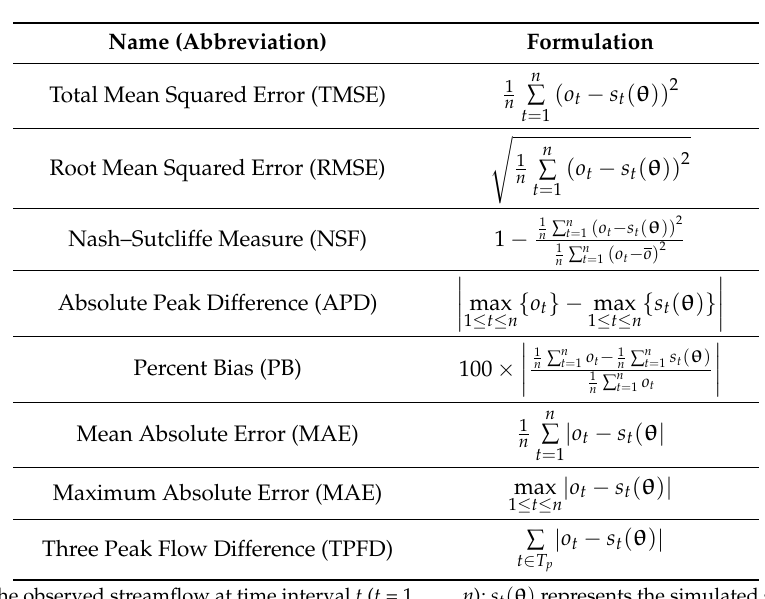
Table 1. Model accuracy indicators (MAIs) and their